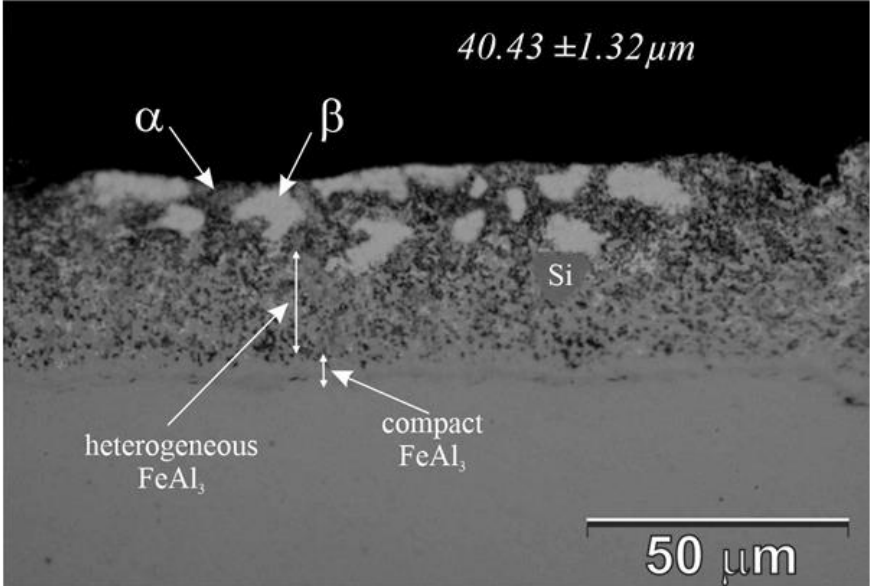
Figure 7. Structure of the reference coating obtained in the ZnAl23Si0.4 bath for corrosion tests. Table 8. The average thickness of coatings on samples for corrosion